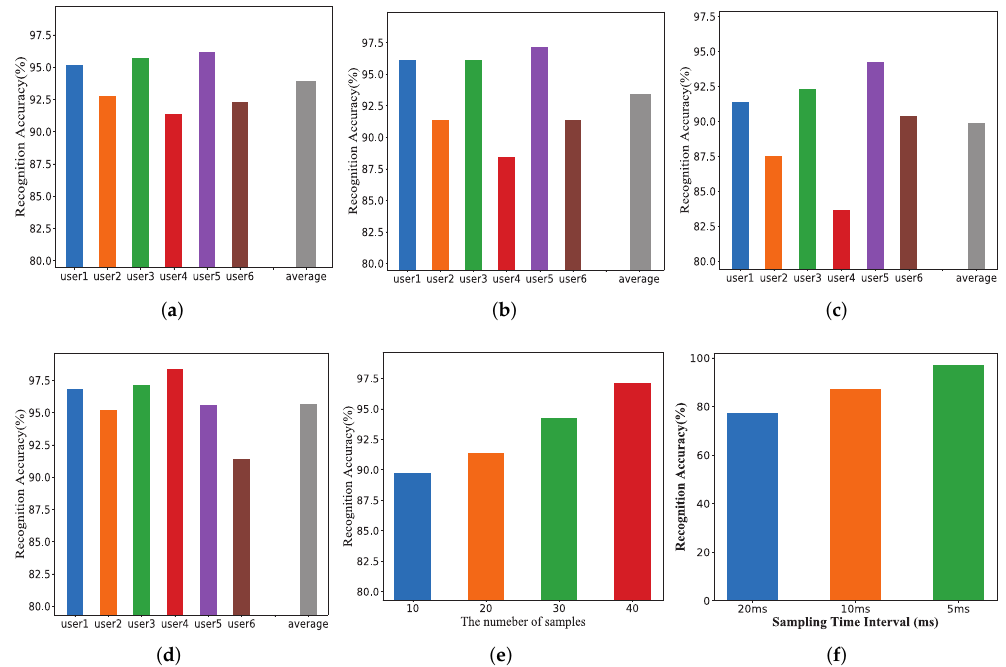
Figure 11. The accuracy of MCSM-Wri using the five validation methods from six users. ( a ) 5-fold cross-validation for user 1 to 6. ( b ) 10-fold cross-validation for user 1 to 6. ( c ) 10-hold-out validation for user 1 to 6. ( d ) Leave-one-out validation for user 1 to 6. ( e ) The impact of the number of samples on accuracy. ( f ) The impact of the sampling rate on